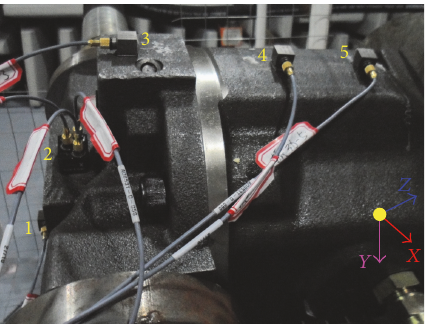
Figure 11: Layout of accelerometers on the pump external surface.